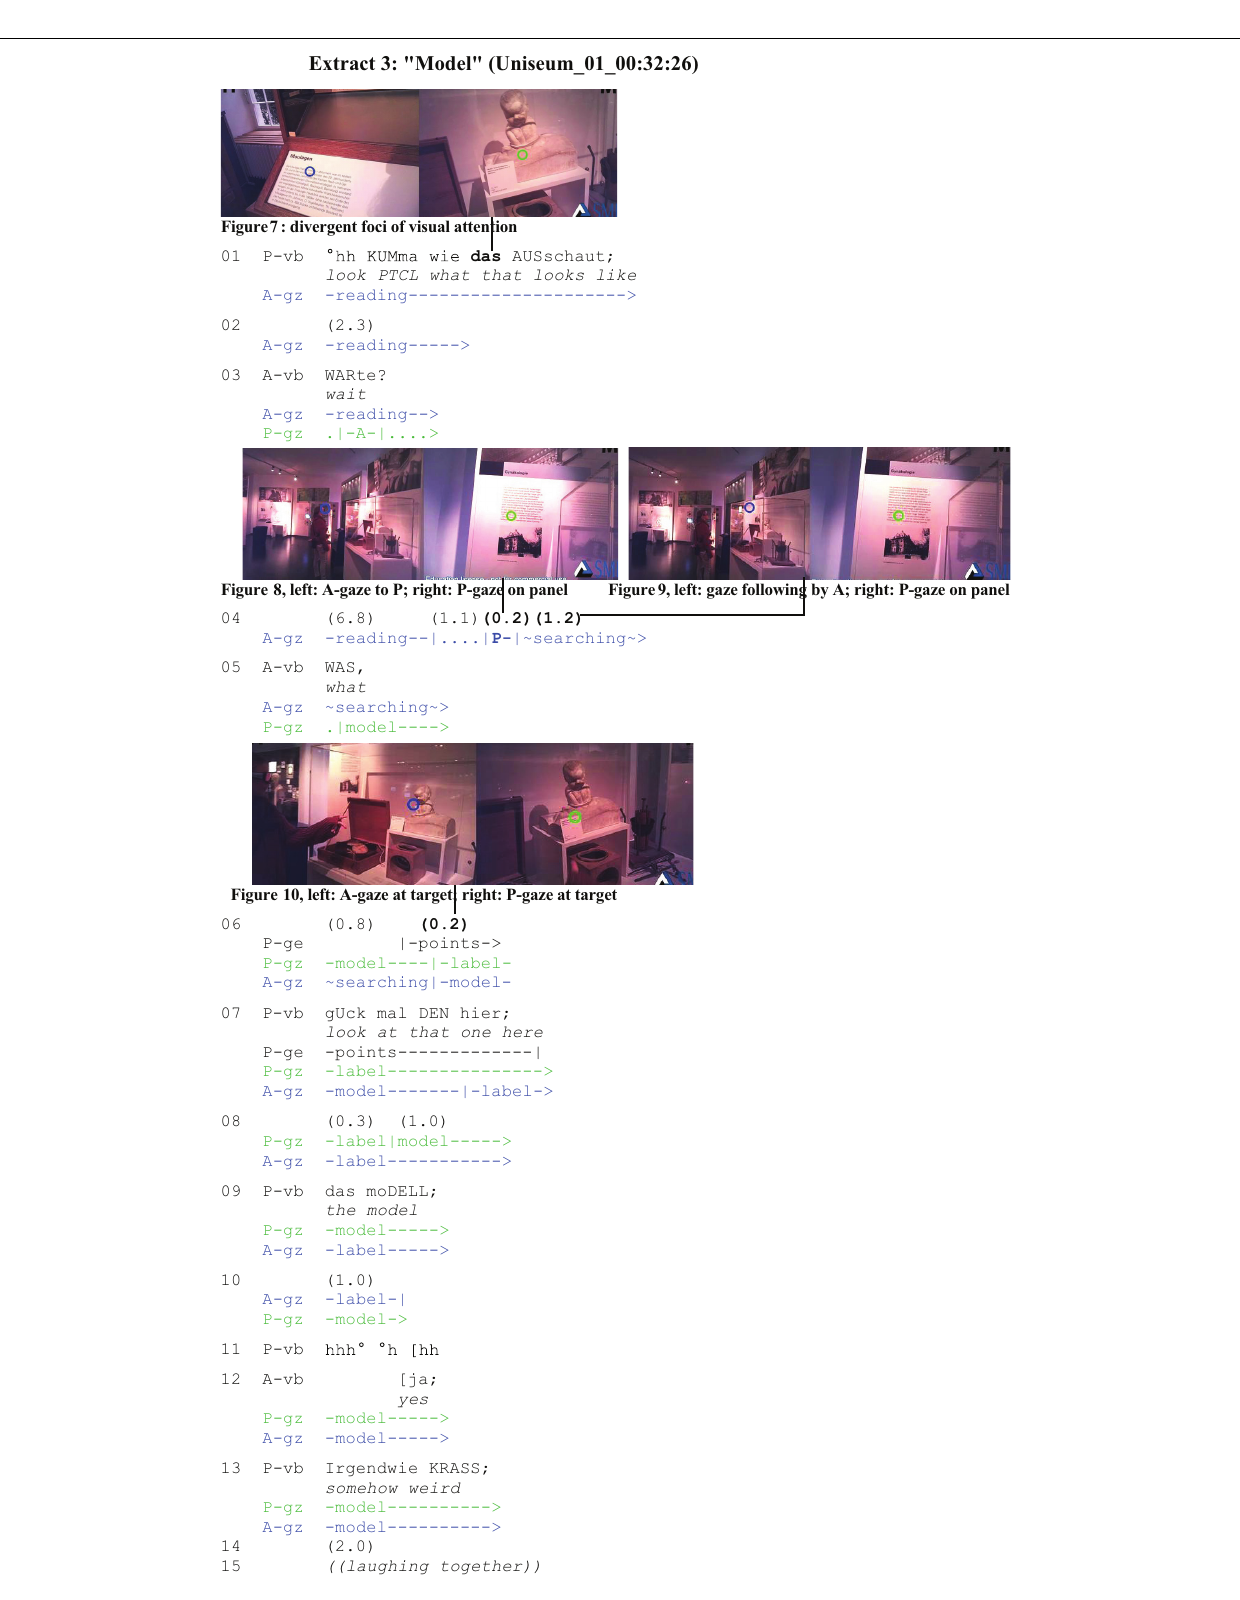
Figure 8, left: A-gaze to P; right: P-gaze on panel Figure 9, left:gaze following by A; right: P-gaze on panel